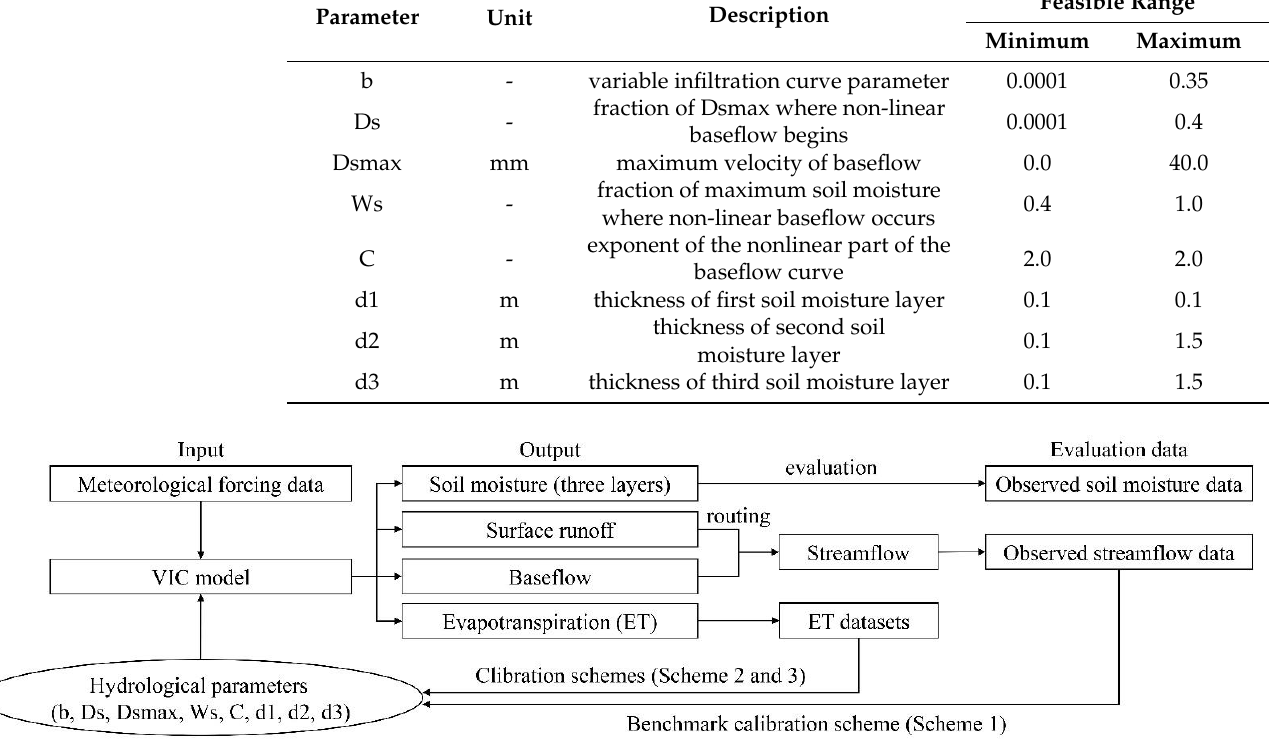
Figure 3. A flow chart of the variable infiltration capacity (VIC) model and calibration schemes. Table 4. Hydrological parameters in the VIC model for calibration.